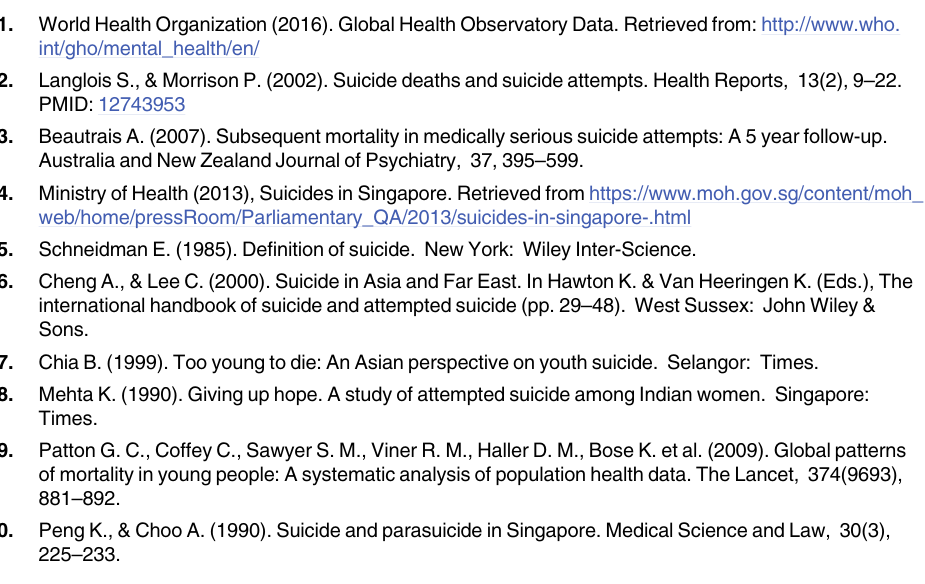
S3 Table. Ethnic difference in suicide attempts with high medical and perceived lethality. S4 Table. Logistic regression predicting likelihood of suicide attempts with high perceived lethality in the major ethnic